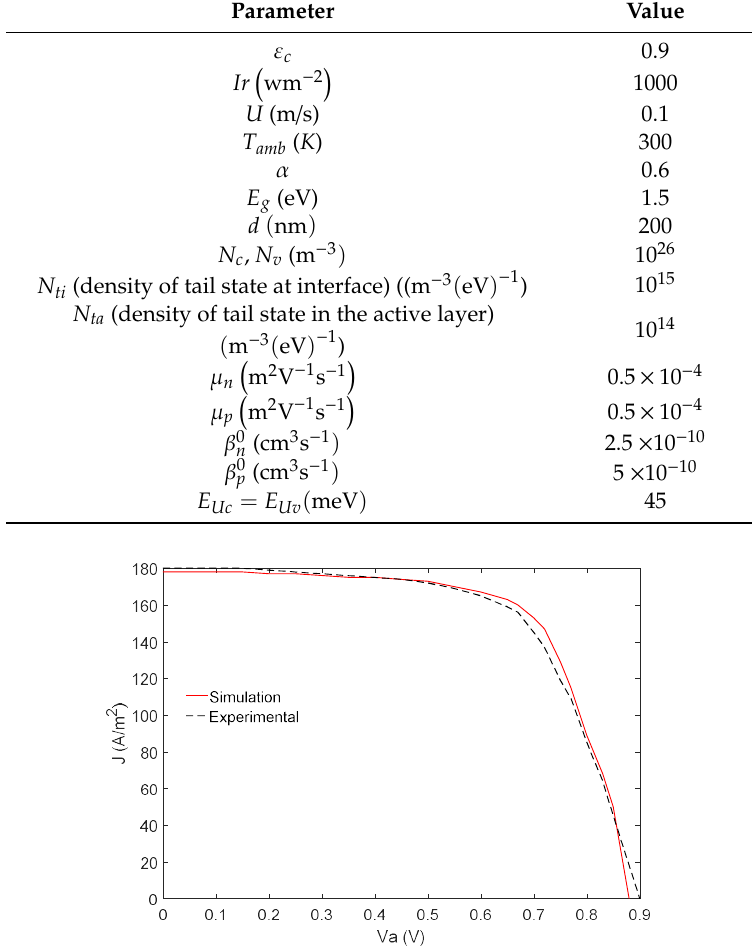
Figure 5. The J − V characteristics of a PSC of structure Glass / PEDOT: PSS / CH 3 NH 3 PbI 3 / PC60BM / Al obtained from our simulation (solid curve) and from experiment [45] (dotted curve) to check the validity of our simulation. Table 1. Input parameters used for simulation in this paper [9] .